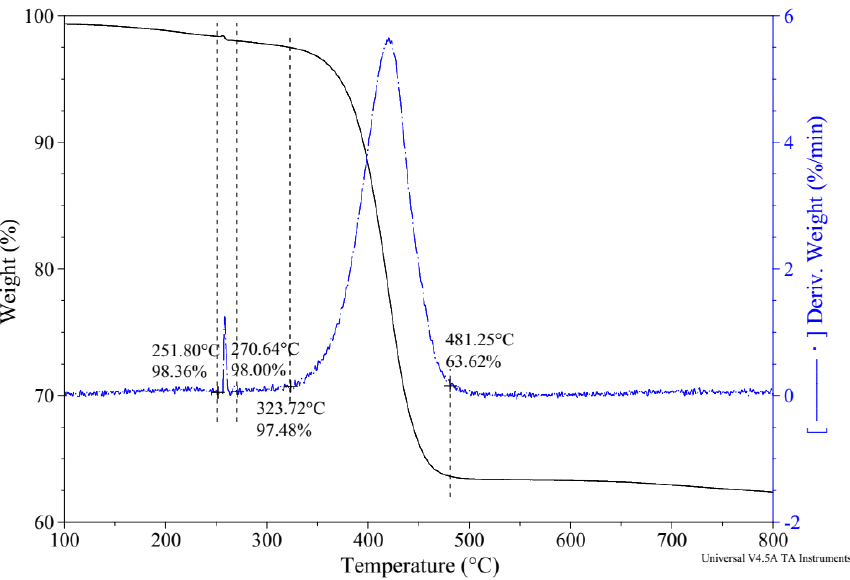
Figure 7. TGA-DTG results of NS-N66 NFs.